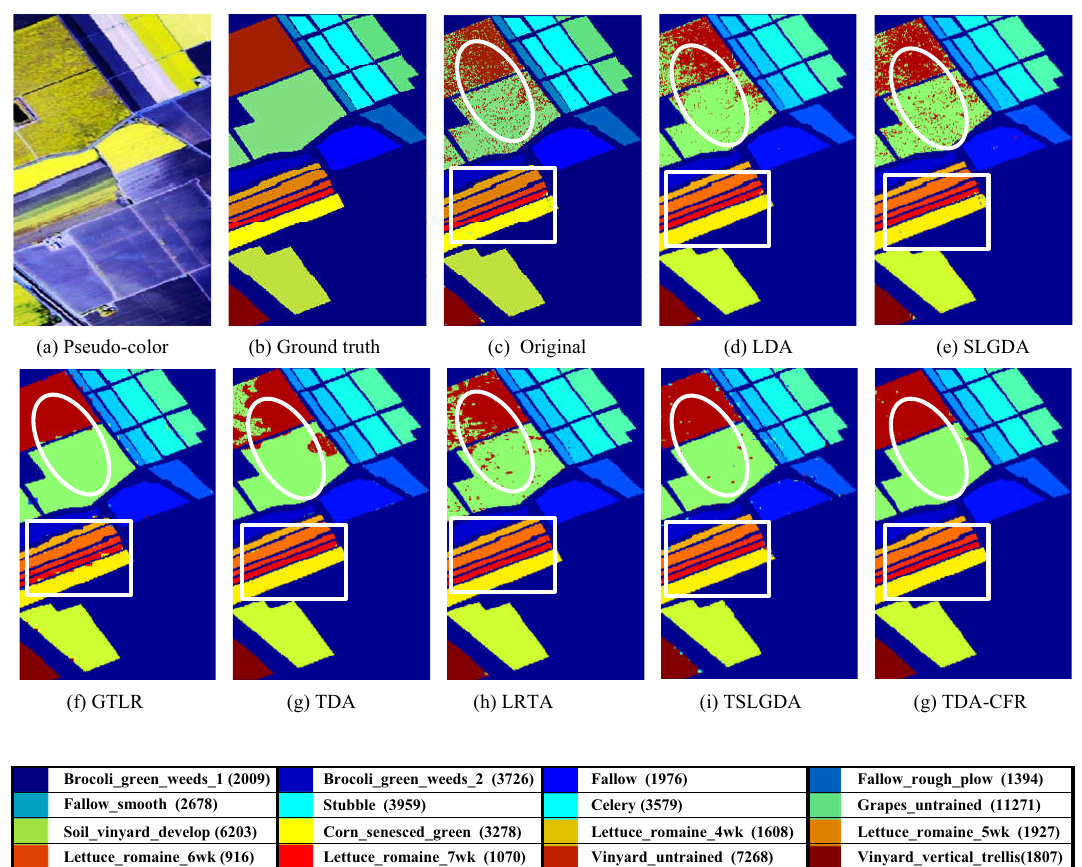
Figure 5. The classification maps on